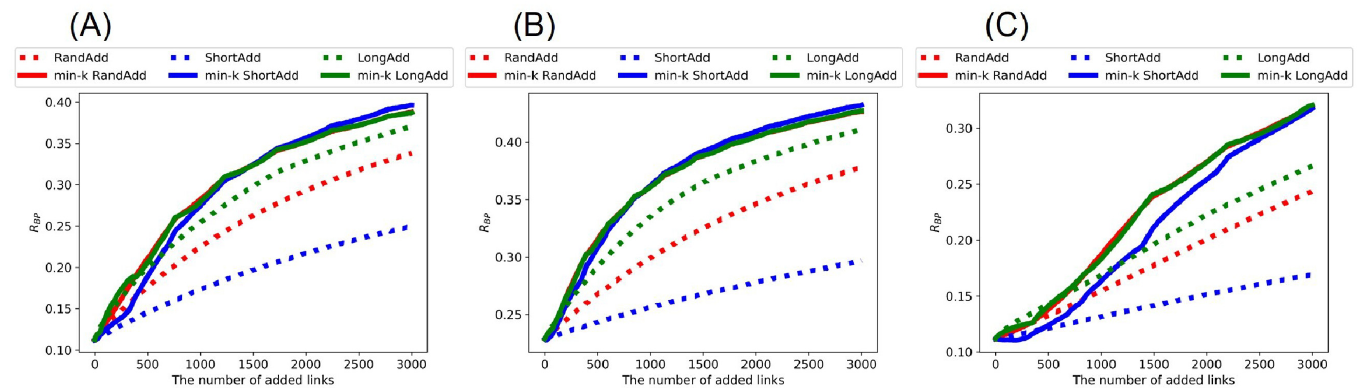
Fig 10. Robustness index against the worst-case BP attacks after adding links to real networks. The min- k RandAdd, min- k LongAdd, and min- k ShortAdd methods (red, green, and blue solid lines) are the most effective for improving the robustness. The initial networks are (A) AirTraffic, (B) Email, and (C) Yeast. The correspondence between lines and methods is the same as shown in Fig